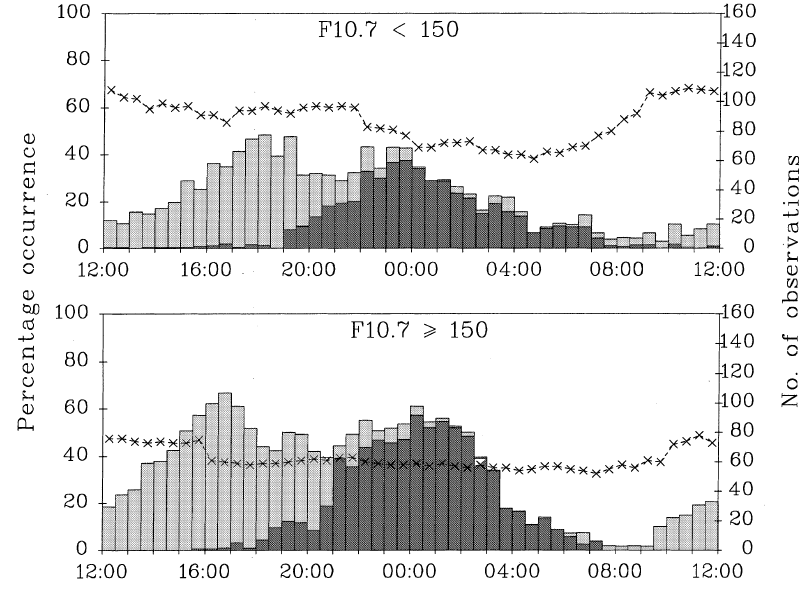
Fig. 3. Variation of the diurnal distribution of enhanced F-region ion velocity with solar activ- ity. The histograms represent the percentage occurrence of enhanced ion flow as a function of universal time ( left hand scale ); light grey shading indicates enhanced ion velocities with a westward zonal component, dark grey indicates those with an eastward zonal component. The line plots , again, indicate the number of observations of each half hour bin ( right hand